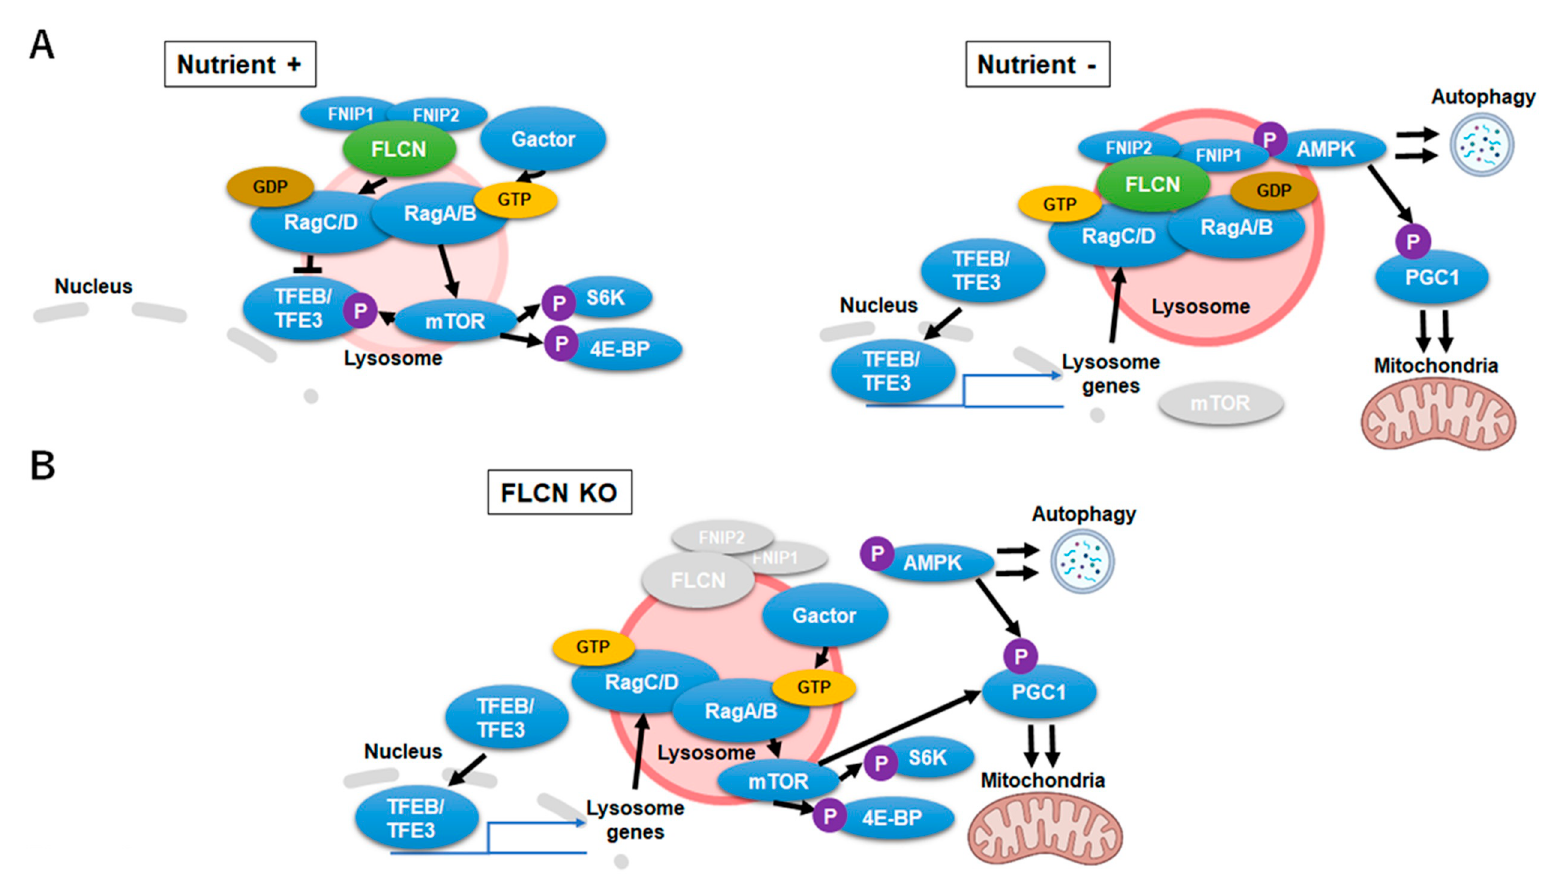
Figure 3. Folliculin-Transcription Factor EB/Transcription Factor Binding To IGHM Enhancer 3 (FLCN-TFEB/TFE3) signaling during nutrient-rich, starvation and FLCN-deficient conditions. ( A ) FLCN-TFEB/TFE3 signaling during nutrient-rich (left) and starvation (right) conditions. Upon starvation, FLCN (LFC) stabilizes on the lysosomal surface which promotes TFEB/TFE3 transcription. ( B ) Signaling alternations during FLCN-deficiency. FLCN-deficiency causes upregulation of the inactive RagC/D GTP which leads to an aberrant activation of TFE3/TFEB and mechanistic target of rapamycin complex 1 (mTORC1) signaling.